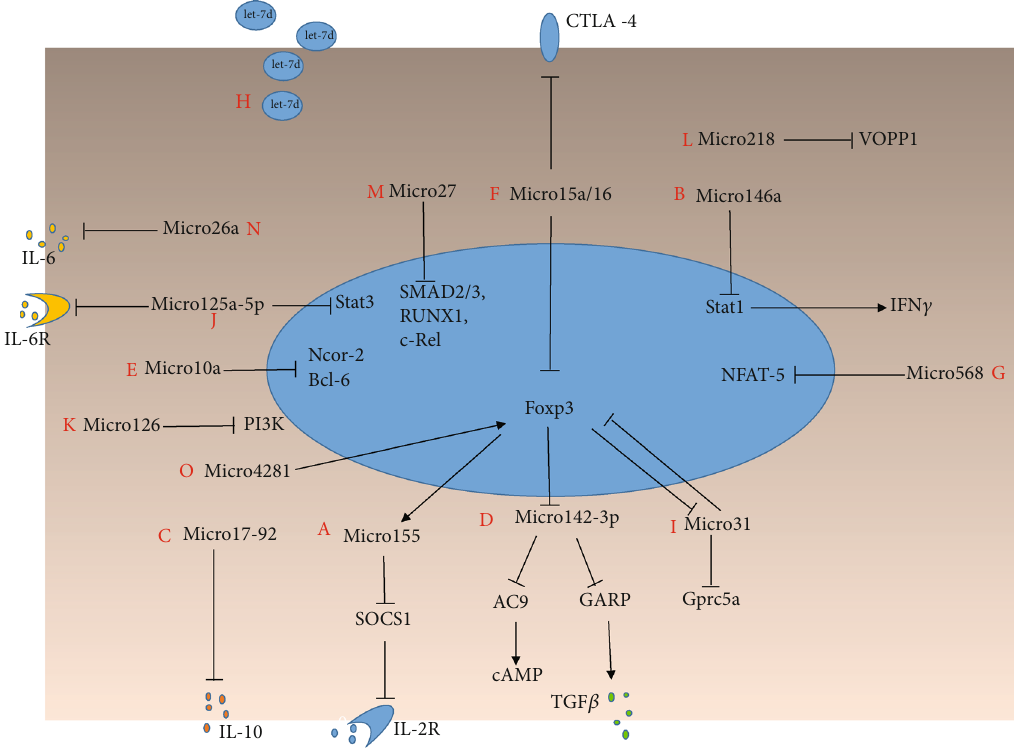
Figure 2: The regulatory roles of microRNAs in Tregs. A — Foxp3 directly regulates the expression of micro155. Micro155 directly targets the 3 ′ UTR of the mRNA of suppressor of cytokine signaling 1 (SOCS1), which suppresses IL-2 signaling. B — Micro146a negatively regulates IFN γ production by directly targeting its key transcription factor Stat1. C — Micro17-92 regulates secretion of the immunosuppressive cytokine IL-10. D — The expression of micro142-3p is negatively regulated by Foxp3 directly or indirectly. Micro142-3p inhibits the production and secretion of cAMP and TGF β by directly targeting adenylyl cyclase (AC) 9 and glycoprotein A repetitions predominant (GARP), respectively. E — Micro10a regulates Treg stability by targeting the transcriptional repressor Bcl-6 and the corepressor Ncor2. F — Micro15a/16 negatively regulates the expression of Foxp3 and CTLA-4. G — Micro568 regulates the activation, di ff erentiation, and function of Tregs by targeting NFAT5. H — Let-7d plays an important role in the exosome-mediated immunosuppressive function of Tregs. I — Micro31 regulates periphery Treg generation by targeting Gpra5a. J — Micro125a-5p regulates the di ff erentiation and function of Tregs by targeting IL-6R and Stat3. K — Micro126 in fl uences the induction and suppressive function of Tregs through the PI3K/AKT pathway. L — Micro218 regulates the amount of Tregs by targeting VOPP1. M — Micro27 impairs the development and homeostasis of Tregs by targeting SMAD2/3, RUNX1, and c-Rel. N — Micro26a plays a vital role in the expansion and function of Tregs by targeting IL-6. O — Micro4281 promotes Tregs generation by binding to the TATA box of promoter of